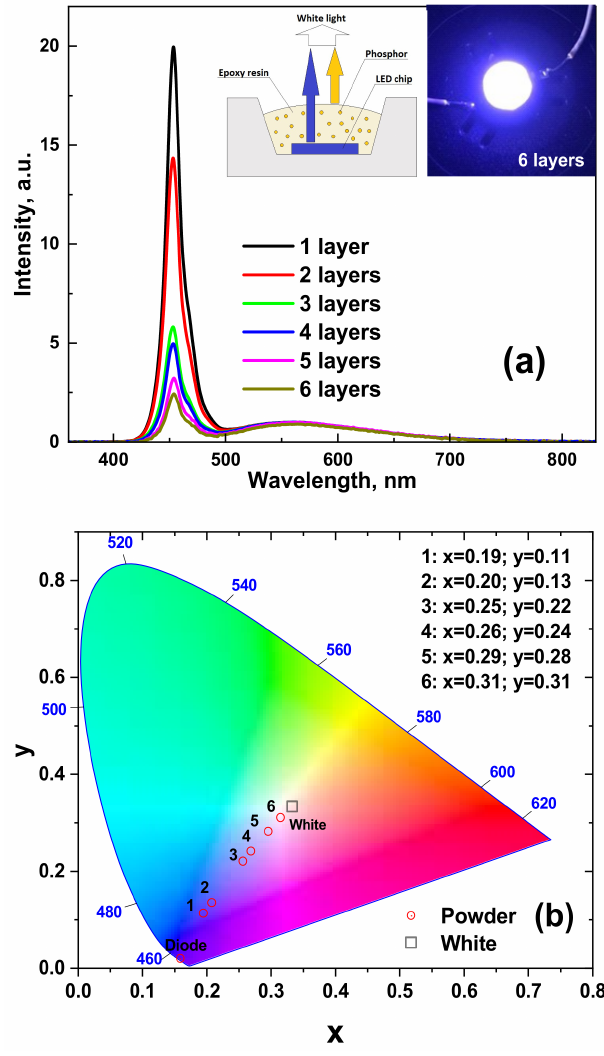
Figure 10. Emission spectrum ( a ) and chromaticity diagram ( b ) of a WLED lamp fabricated on the base of 450 nm LED chip and CYMSSG:1%Ce phosphor. Table 6. CIE chromaticity coordinates of a WLED lamp fabricated on the base of 450 nm LED chip and CYMSSG:1%Ce